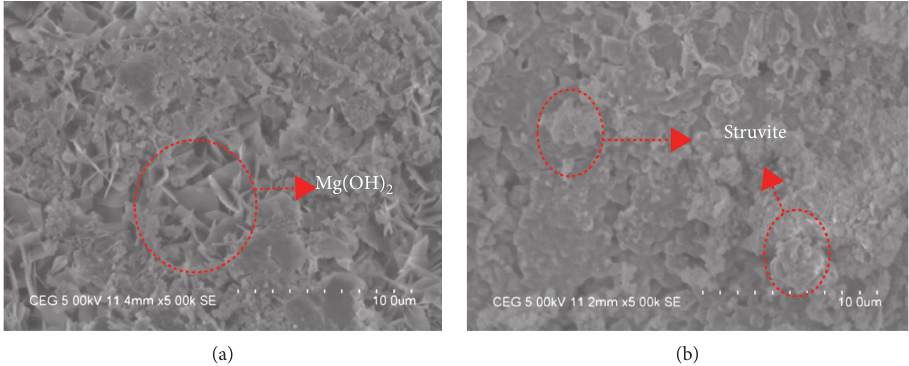
Figure 5: Scanning electron microscopic image of: (a) MB sample and (b) MPB